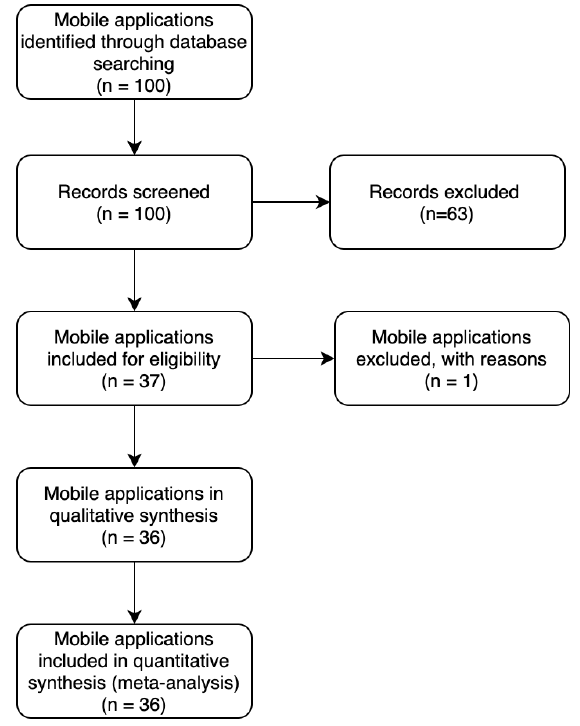
Figure 3. Mobile applications